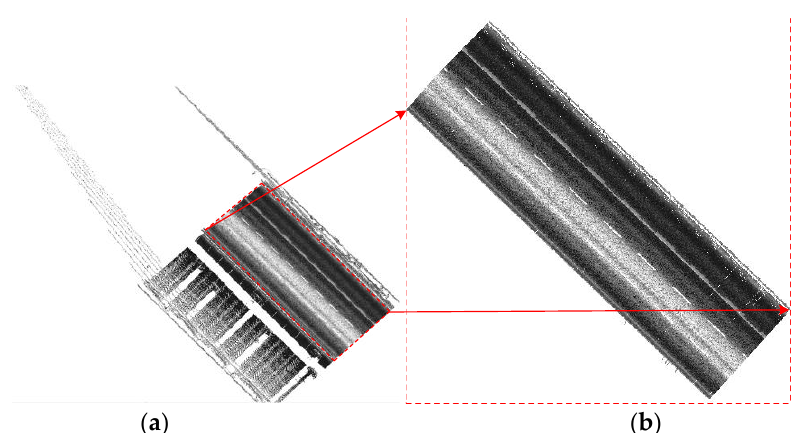
Figure 13 . Pavement point cloud extraction. ( a ) Original point cloud; ( b ) pavement point cloud.